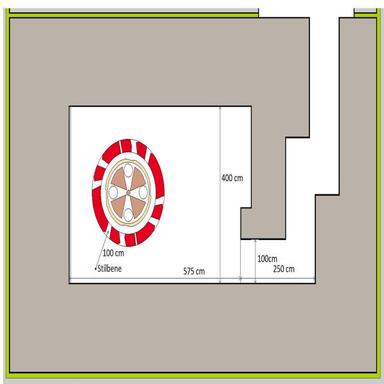
Schematic drawing of the cyclotron laboratory with cyclotron. Distance from water target to Stilbene detector is visualized.